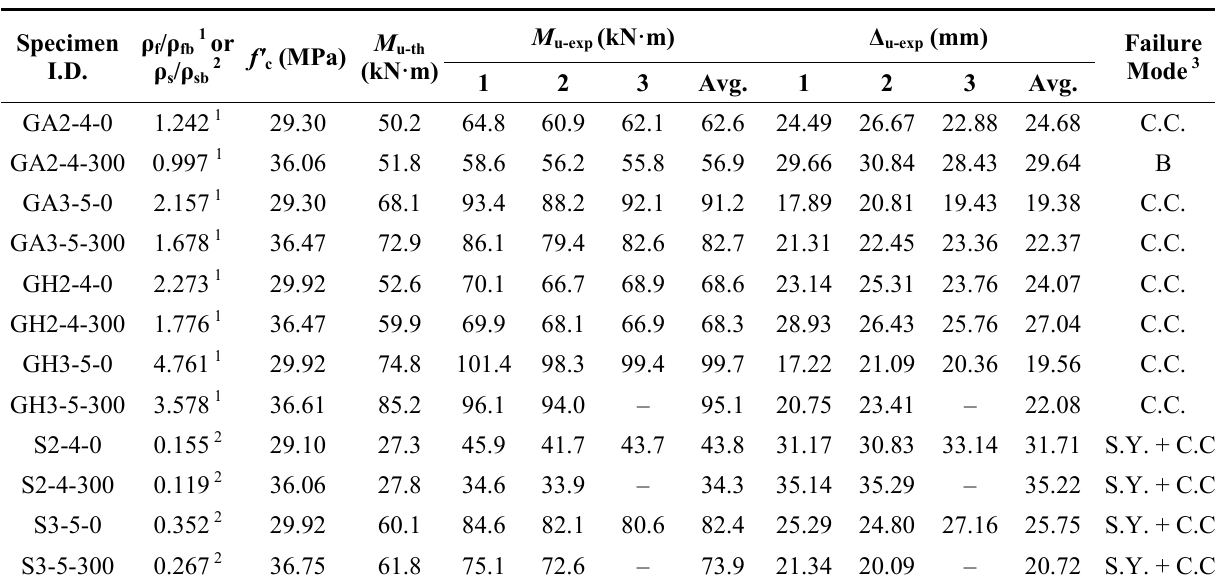
Table 2. Summary of the test